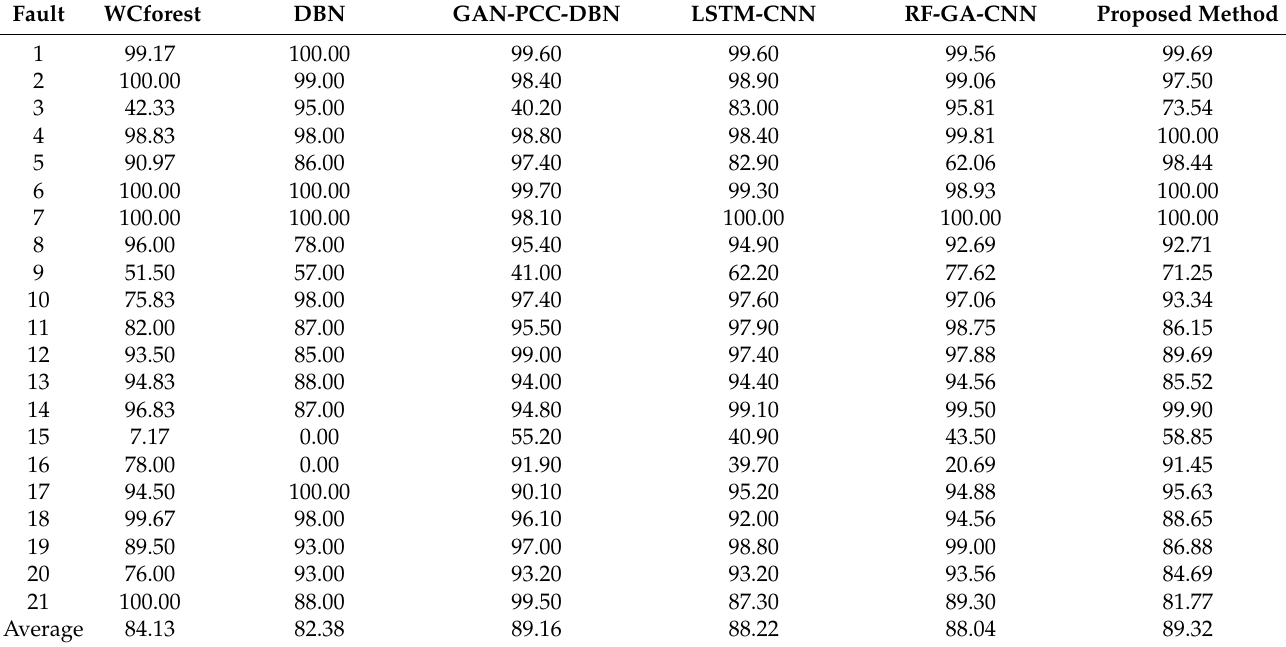
Table 7. Comparison of FDR (%) of different